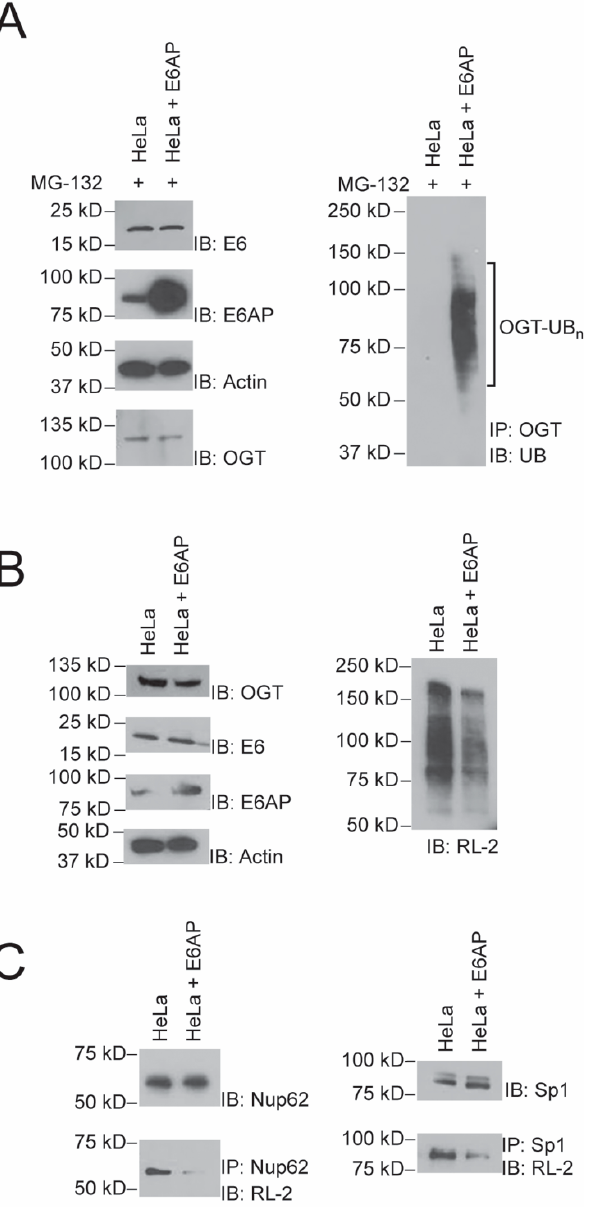
Figure 4. E6AP regulated protein O-GlcNAcylation in HeLa cells by inducing the degradation of OGT. ( A ) Overexpression of E6AP in the presence of proteasome inhibitor MG132 in Hela cells was confirmed by immunoblotting with an anti-E6AP antibody (left panels). Ubiquitination of OGT in the presence of MG132 in HeLa cells was assayed by immunoprecipitation with an anti-OGT antibody and immunoblotting with an anti-UB antibody (right panel). Ubiquitination of OGT was compared between blank HeLa cells (HeLa) and HeLa cells expressing recombinant E6AP (Hela+E6AP). ( B ) Levels of OGT and protein O-GlcNAylation compared between HeLa and HeLa+E6AP cells. OGT levels were probed in two types of cells on the Western blot with an anti-OGT antibody (left panels). The level of O-GlcNAc modification of cellular proteins was detected with an anti-O-GlcNAc antibody (RL-2) (right panel). ( C ) E6AP expression negatively regulated the O-GlcNAcylation of two known OGT substrates, Nup62 and Sp1. Cell lysates of HeLa and HeLa+E6AP cells were immunoprecipitated with substrate-specific antibodies (anti-Nup62 or anti-Sp1) and immunoblotted with the RL-2 antibody to detect the levels of O-GlcNAc-modified proteins. In ( B , C ), cells were not treated with MG132 to allow the degradation of OGT induced by ubiquitination catalyzed by the E6AP–E6 pair.